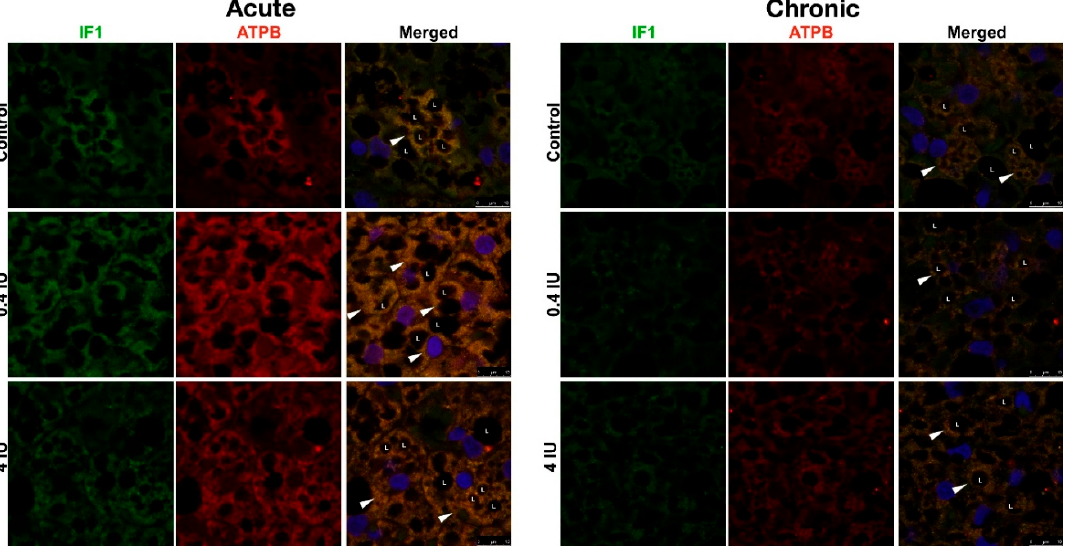
Figure 13. Immunofluorescence of IF1/ATP synthase in BAT following acute and chronic insulin treatment. Double labeling with antibodies against IF1 (green) and ATP synthase (red). Harlequin effect is shown with arrowheads. L—lipid body. Nuclei were stained with Sytox Orange. Scale bar = 10 µm.